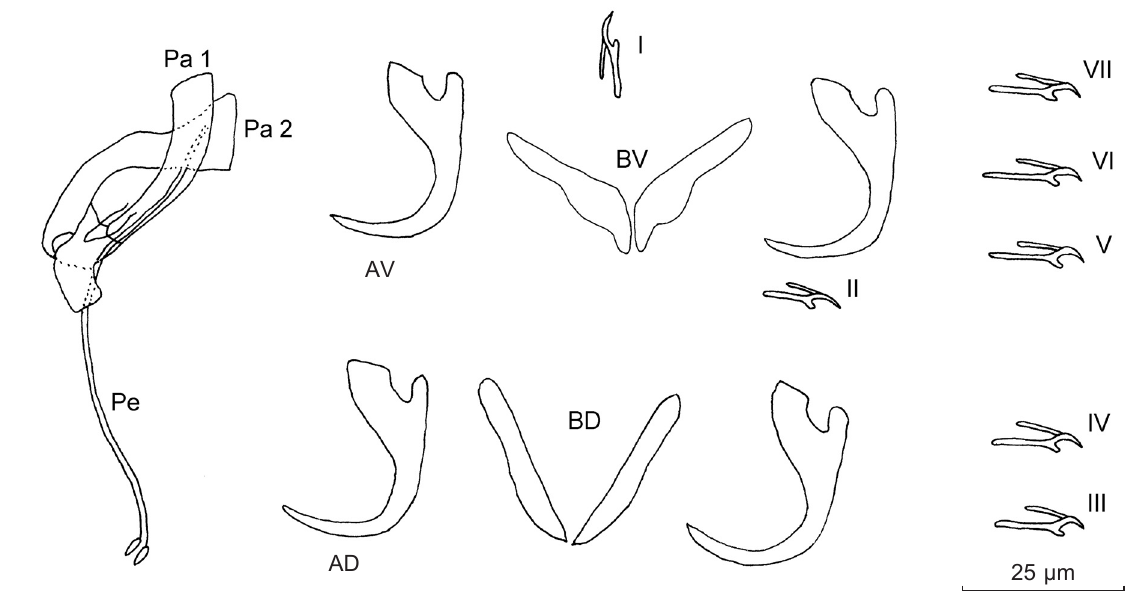
Fig. 2. – Bouixella gorei n. sp.